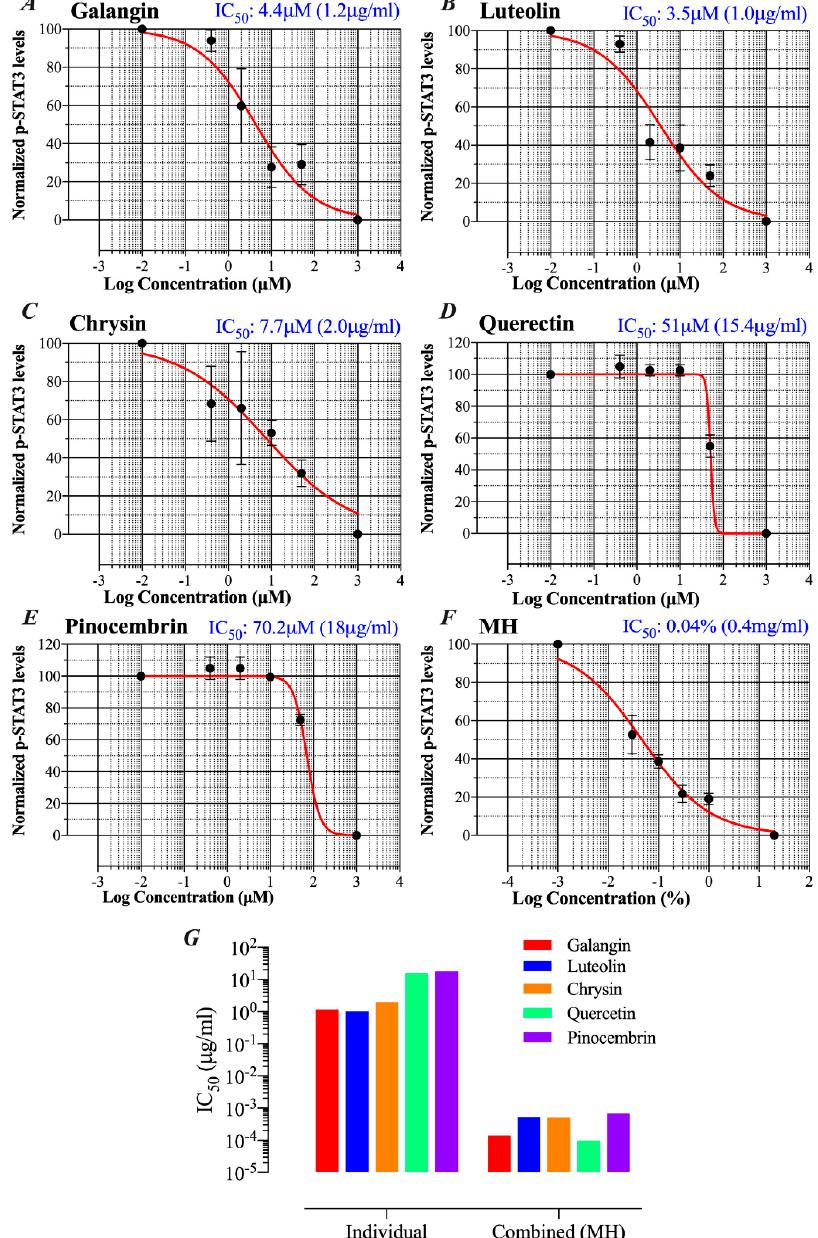
Figure 6. Comparative capacities of flavonoid compounds and MH to inhibit p-STAT3. Following a 1 h-treatment with flavonoids or MH, changes in p-STAT3 levels in breast cancer cells were used to calculate the approximate IC 50 doses (concentrations that induce 50% inhibition in p-STAT3 levels). Cells were either untreated (control) or treated with various concentrations (0.4–50 µ M range) of galangin ( A ), luteolin ( B ), chrysin ( C ), quercetin ( D ), and pinocembrin ( E ). For comparison, the IC 50 was also estimated for cells treated with MH (0.03%–1% w / v) (F). The IC 50 determination was done by nonlinear regression best-fit curve analysis (GraphPad Prism) using 10 − 2 µ M and 10 3 µ M to represent minimum (untreated control) and maximum doses (theoretical estimate). For MH treatment, the minimum and maximum doses were 10 − 3 , and 20% MH, respectively. ( G ) Comparison of IC 50 values for pSTAT3 inhibition of the di ff erent flavonoids when used alone or as part of the whole MH solution. The data are representative of at least duplicate experiments for each flavonoid compound and four experiments for